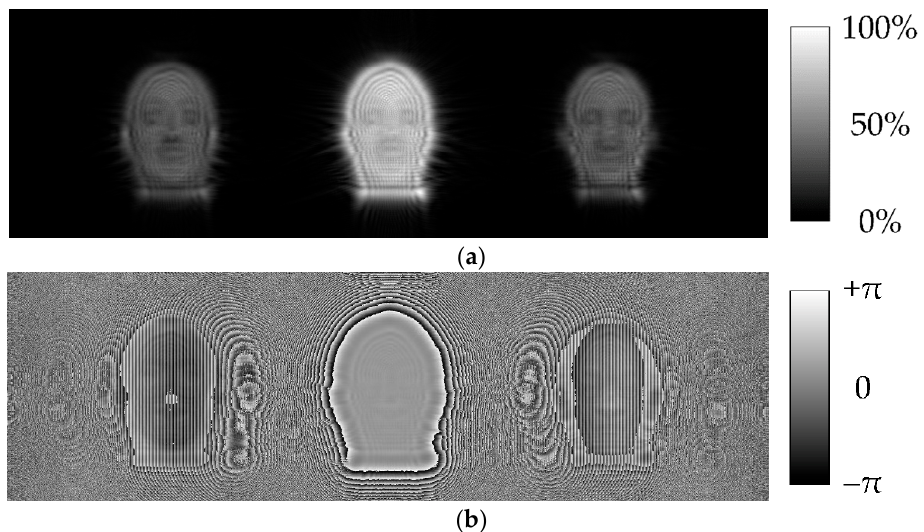
Figure 5. Fresnel spectrum from the hologram shown in Figure 3: ( a ) the amplitude component of the spectrum with a colorbar from 0 to 100%; ( b ) the phase component of the spectrum with a colorbar from − π to + π .